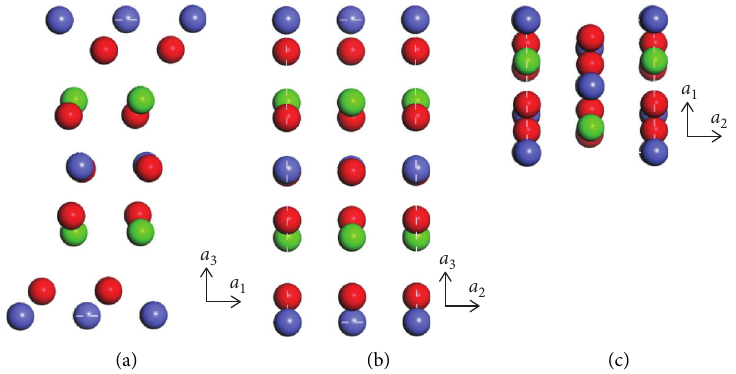
Figure 2: Schematical diagram of sandwiched Ca projection.